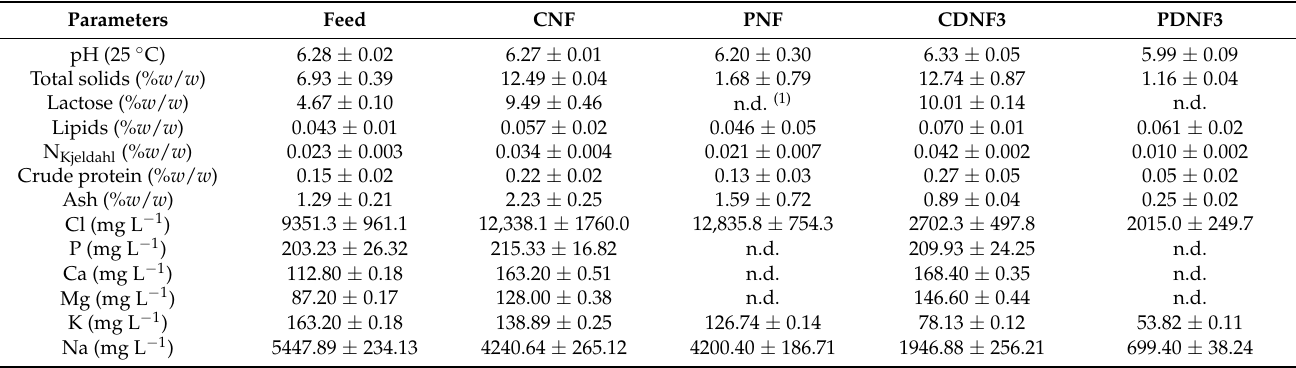
Table 6. Physicochemical characterization of NF and DF/NF